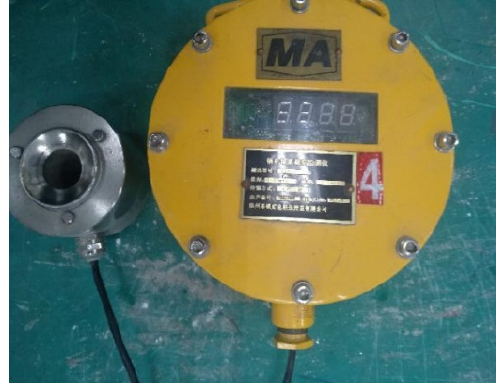
Figure 11. Load tester of the GDP60 bolt.